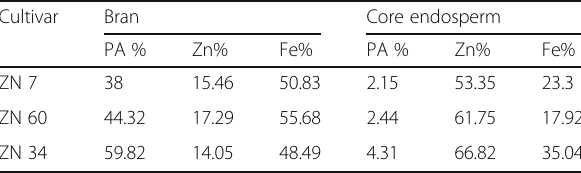
Table 3 Distribution of PA, Zn and Fe in Bran and Core Endosperm of three indica Rice Cultivars (Wang et al. 2011)